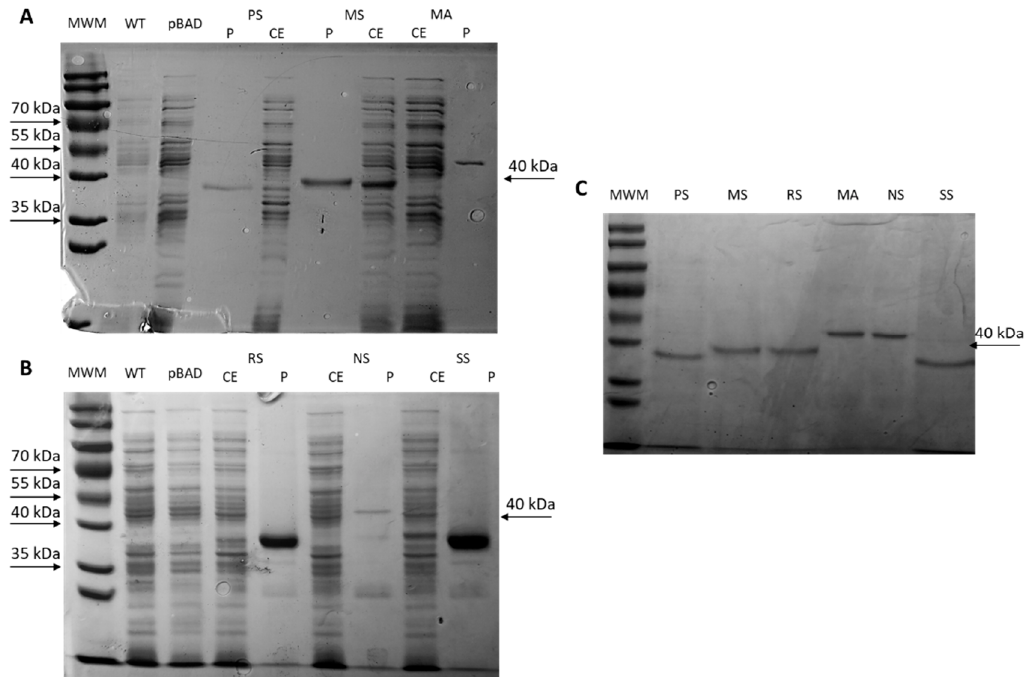
Figure 6. Purification and SDS ‐ PAGE quality control of six expressed Efes; CE: unpurified crude extract, P: purified protein; WT: BL21 wild type; pBAD: BL21 with pBAD vector. ( A ) Expression and purification of Efe_PS, Efe_MS, and Efe_MA constructs; ( B ) Expression and purification of Efe_RS, Efe_NS, and Efe_SS constructs; ( C ) Quality control showing equal loadings of the six purified